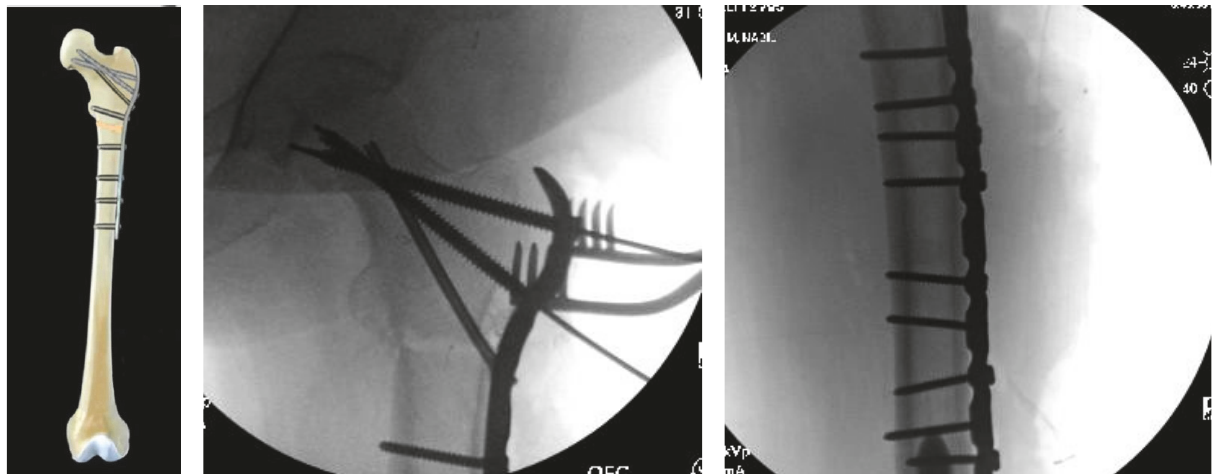
Figure 6: Extramedullary fixation of subtrochanteric femur fractures: This diagram illustrates and provides radiographs of the use of a proximal femoral locking plate construct for the treatment of subtrochanteric femur fractures.